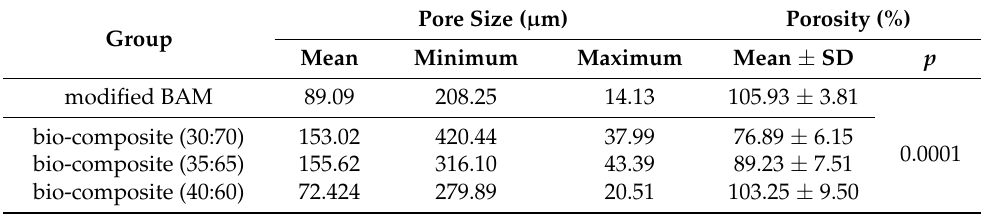
Table 1. The pores size and porosity of modified BAM and all types of bio-composites. Pore Size ( µ Group